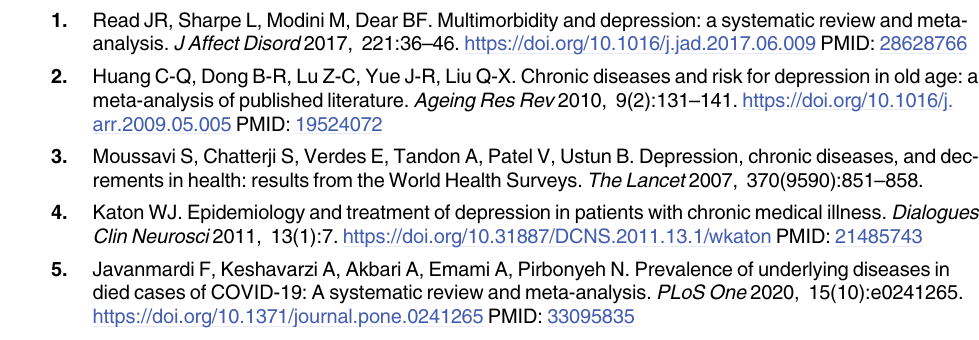
S1 Table. Information on chronic physical conditions (n = 486) �